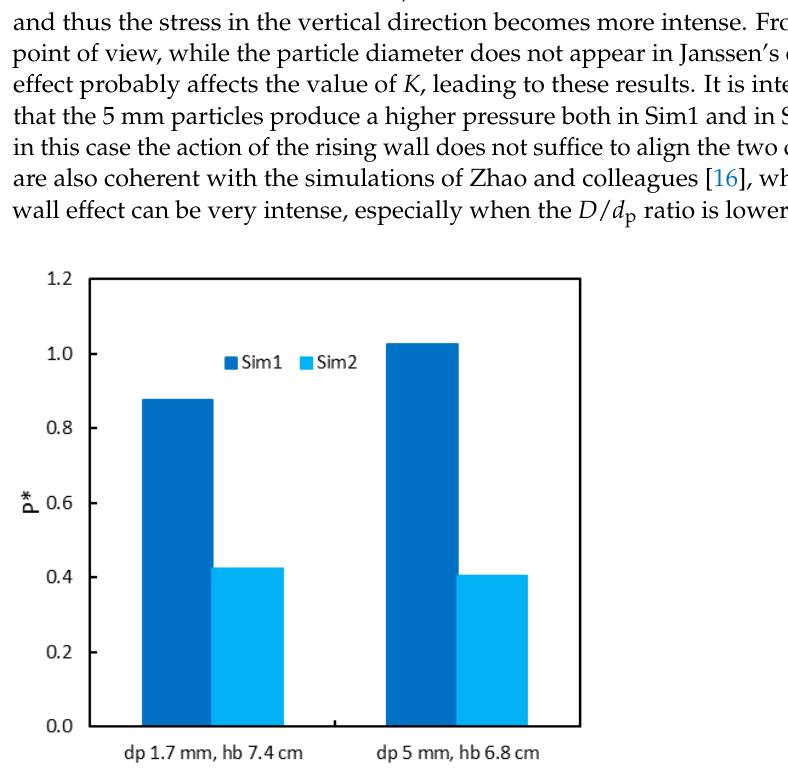
Figure 13. Pressure at the bottom in the 61 mm column upon varying the particle diameter.